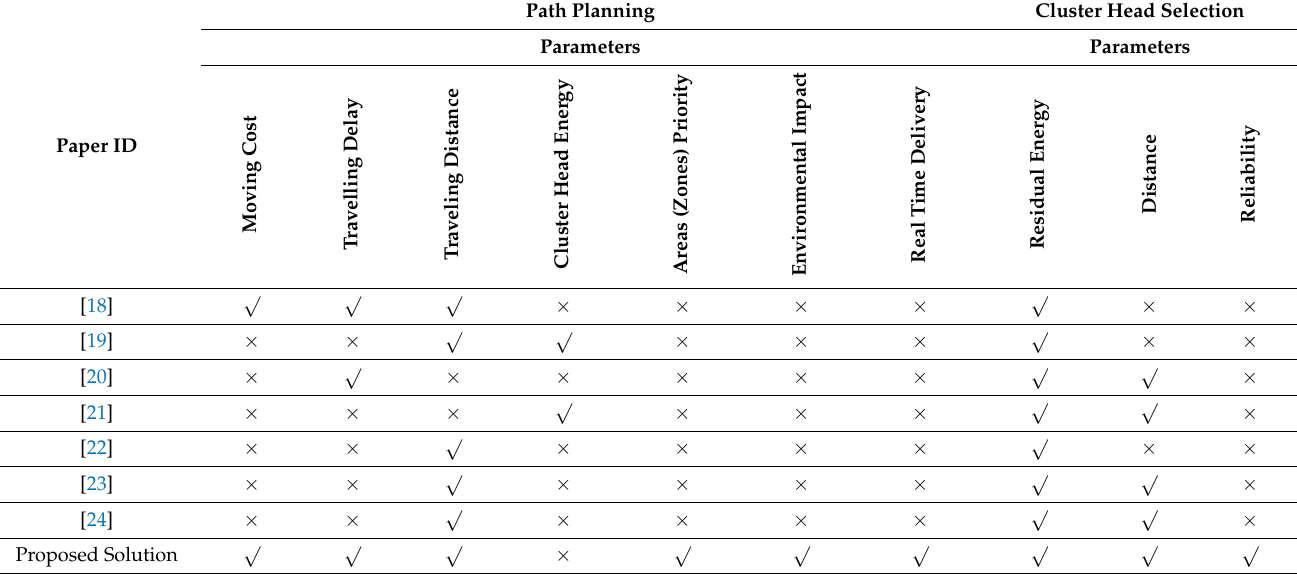
Table 1. A comparative summary of the algorithms mentioned above and the proposed ones.